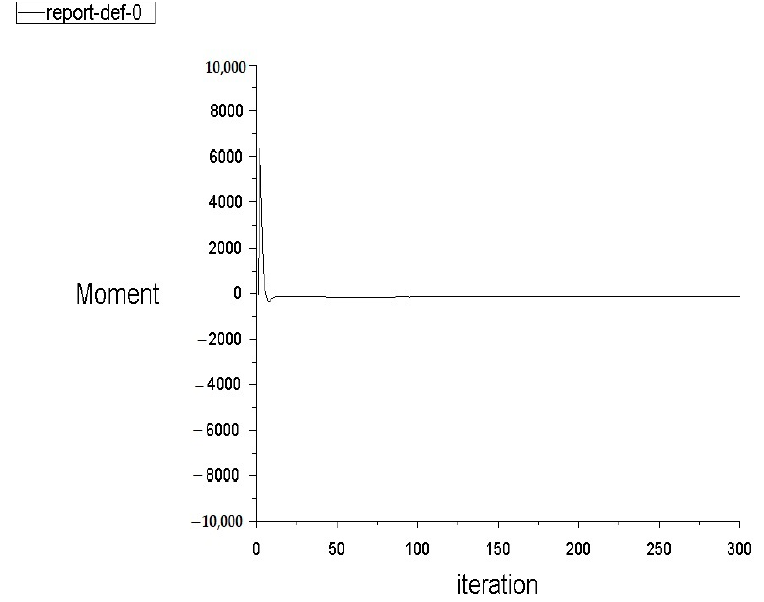
Figure 7. Monitoring the convergence of the moment at the turbine parts.